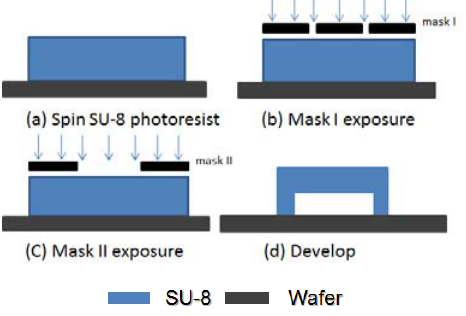
Figure 3. Schematic diagram of exposure dose method for making platform